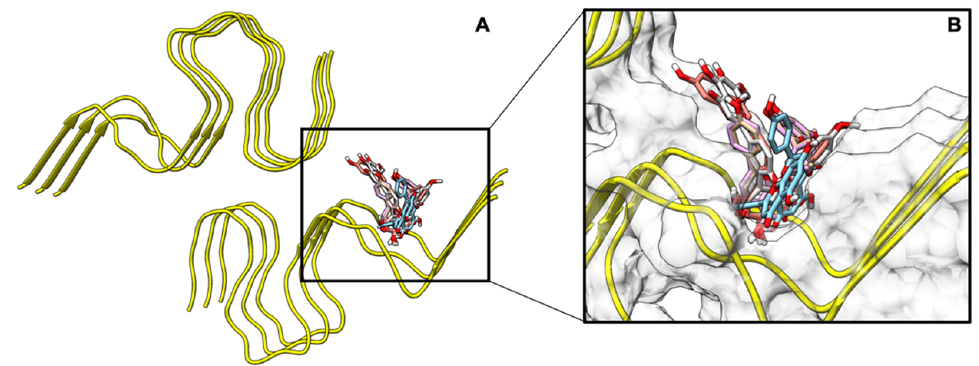
Figure 3. Results from docking biflavonoids to A β 42 (PDB: 2NAO). ( A ) Average weighted docking scores ± S.E.M. for the most negative binding cluster for each biflavonoid calculated from the AutoDock Vina scoring function via the PyRx interface. Simulations were performed with A β 42 in the presence of amentoflavone (AMF), sequoiaflavone (SQF), bilobetin (BIL), sotetsuflavone (STF), and podocarpusflavone (PCF). ( B ) Experimental EC 50 values plotted against the average weighted AutoDock Vina docking scores for each biflavonoid cluster bound to the A β fibril showing a positive correlation (R 2 : 0.866, p = 0.022).